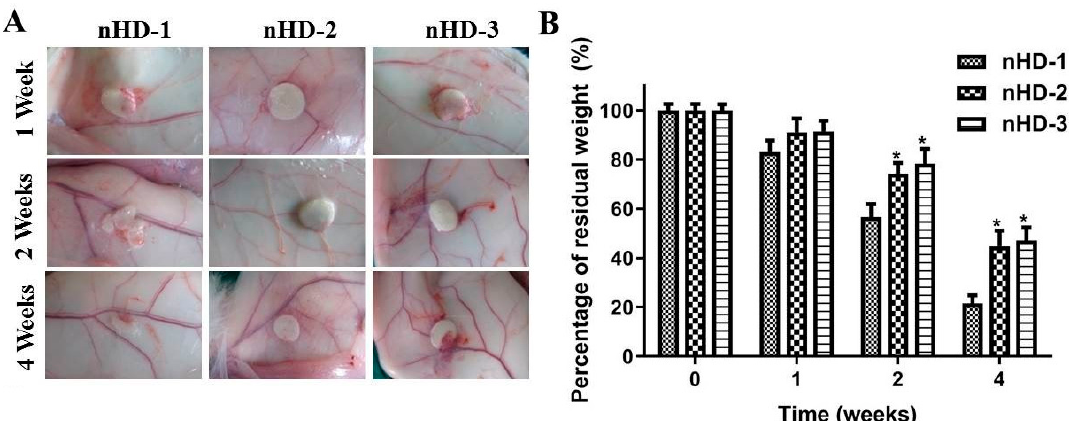
Figure 8. ( A ) The morphologies of tissues around the nHD-1, nHD-2 and nHD-3 scaffolds after 1, 2 and 4 weeks of subcutaneous implantation in New Zealand rabbits. ( B ) The percentage of residual weight for three nHD scaffolds after implantation in New Zealand rabbits at 1, 2 and 4 weeks; * p < 0.05 compared with nHD-1 scaffolds.